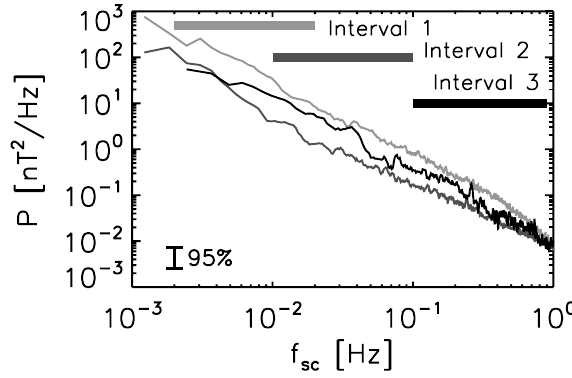
Fig. 2. Frequency spectra of magnetic field fluctuations in the three analyzed intervals: the upper curve in thin color is the spectrum for the interval 1, the lower curve the interval 2, and the middle curve in black the interval 3. The data are taken from fluxgate magnetometer on board Cluster, and the spectra are averaged over 4 spacecraft. Horizontal bars represent frequency ranges used in the wave vector analysis. Vertical bar with notation “95%” at bottom left represents the confidence interval for the average number of sub-intervals used in the